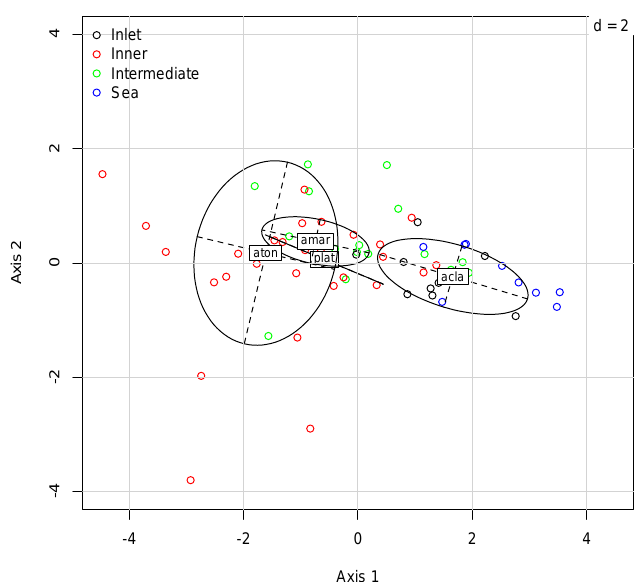
Figure 10. OMI analysis. Realized niche position of Acartia species in the Lagoon (2014–2017 dataset). The site scores are projected on the same first two axes of the OMI analysis, and the habitat type is highlighted (Labels: acla = A. clausi ; aton = A. tonsa ; plat = P. latisetosa ; and amar = A. margalefi ).